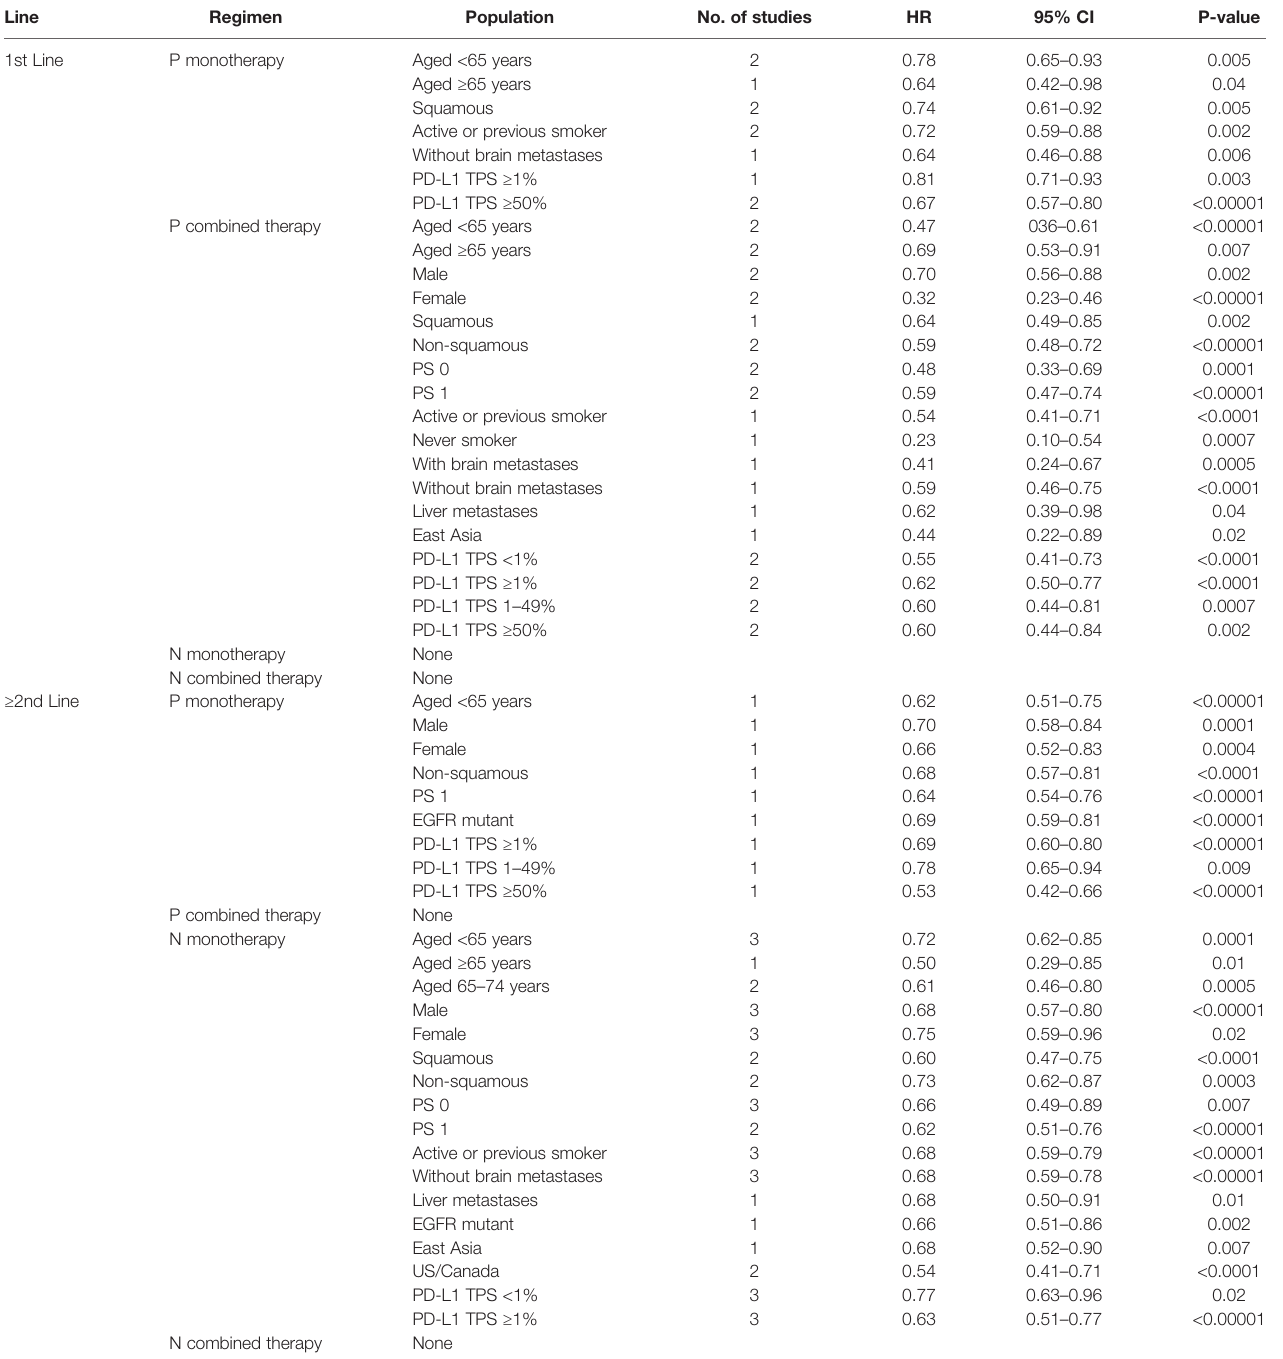
TABLE 2 | Different treatment lines and regimens with OS bene fi ted from PD-1 inhibitor over non-PD-1 inhibitors in targeted patients.